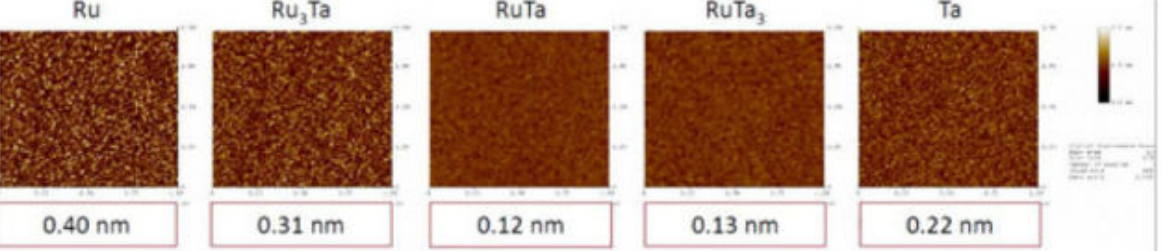
Figure 8. AFM images showing RMS values of Ru and various alloys deposited on 30 nm film